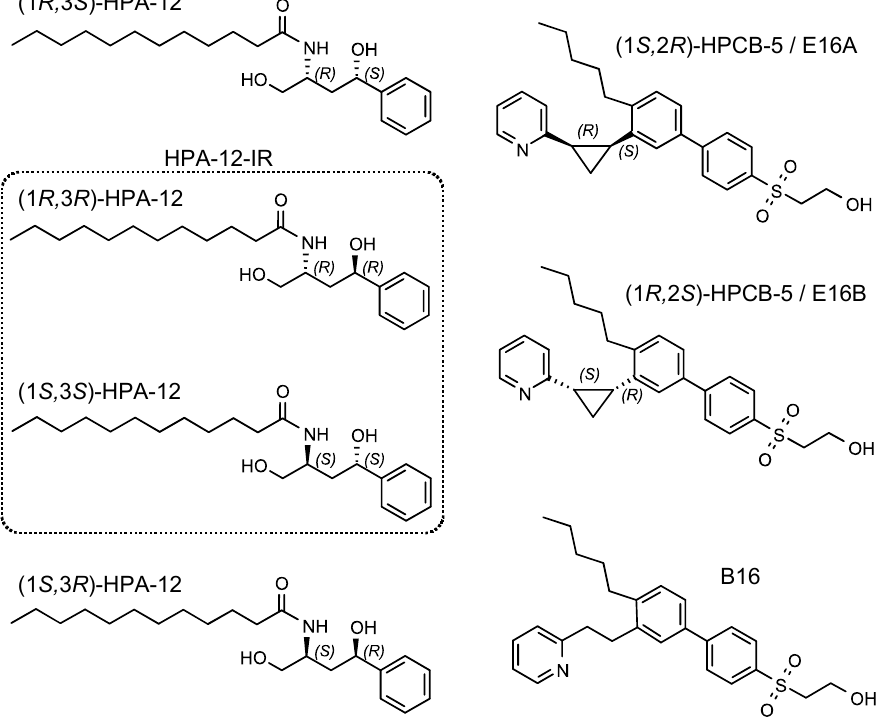
Figure 1. Structures of ceramide mimetic and nonmimetic CERT inhibitors and their relatives. The chemical structure and stereo-configuration of the ceramide mimetic and nonmimetic CERT inhibitors and their relatives used in this study are shown. The rounded rectangle represents the racemic mixture of HPA-12-IR.